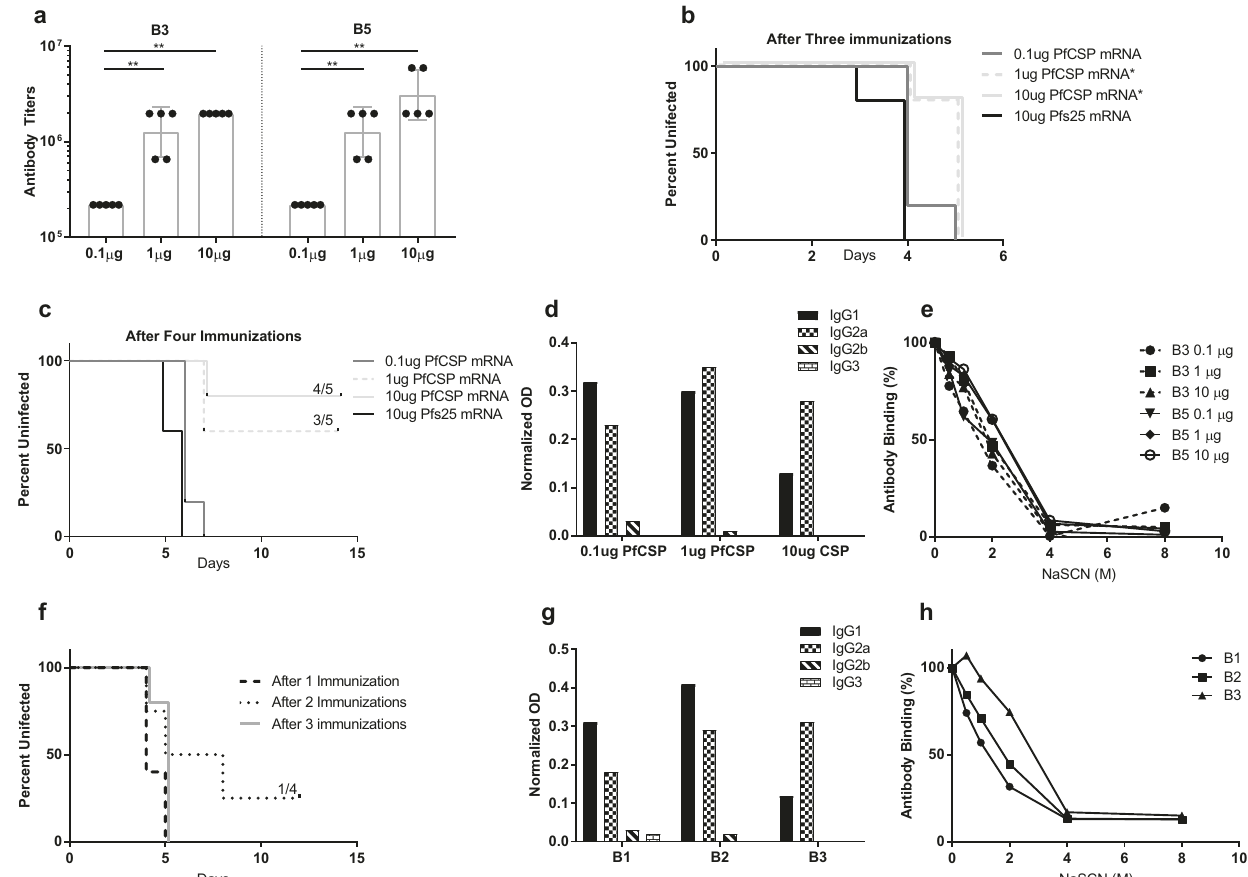
Fig. 8 Evaluation of varying vaccine doses and immunization schedules of PfCSP mRNA-LNPs. Details of immunization and challenge are described schematically in Fig. 6a – c. a Anti-PfCSP antibody responses from B3 and B5 (Fig. 6c) were analyzed by ELISA and are reported as the geometric mean endpoint titers with 95% con fi dence intervals. b Kaplan-Meier survival curves representing outcome of sporozoite challenge after three immunizations with PfCSP mRNA-LNP ( N = 5 per groups). Mice after challenge were observed for 12 days by microscopic examination of giemsa-stained blood smears. Following the fi rst challenge, mice were treated and immunized a fourth time and challenged as shown in Fig. 6c. c Kaplan-Meier survival curves after repeat challenge ( N = 5 per group). Panels d shows antibody isotypes from the bleed, B5, and ( e ) shows antibody-antigen avidity index from the bleeds, B3 and B5 (Fig. 6c). Panels f, g , and h show Kaplan-Meier survival curves for mice immunized with 10 μ g PfCSP mRNA-LNP ( N = 5 per group except mice receiving 2 immunizations, N = 4) and challenged after each immunization (Fig. 6a – c), anti-PfCSP antibody isotypes and anti-PfCSP avidity index, respectively. Mann – Whitney U test was used for statistical analysis of antibody titers, while log rank (Mantel Cox) test was used for the analysis of survival curves (* p < 0.05; ** p <